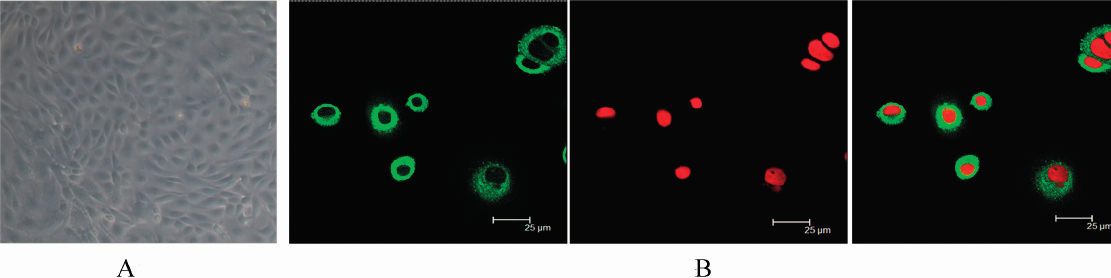
Figure 1. Morphology of cultured and identified dairy cow mammary epithelial